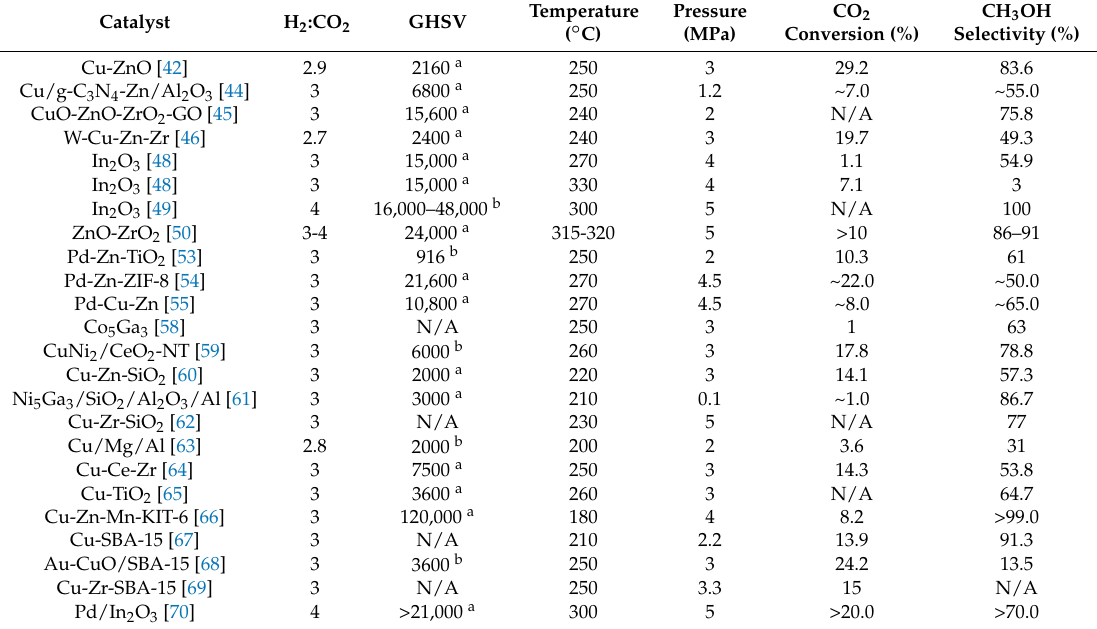
Figure 12. Possible catalytic mechanism of CO 2 hydrogenation over Cu − Ni/CeO 2 − NT, reproduced with permission from [59]. Copyright American Chemical Society, 2018. Table 3. Catalytic performance of several catalytic systems for CO 2 hydrogenation into CH 3 OH, in terms of CO 2 conversion and CH 3 OH selectivity, along with the reaction conditions.